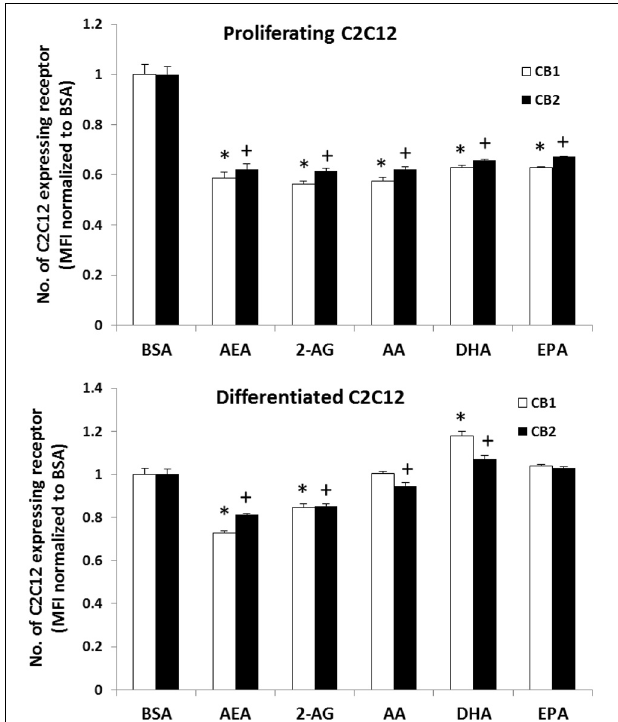
FIGURE 2 | FACS flow cytometry analysis of CB1 and CB2 expression in proliferating and differentiated C2C12 myoblast cultures treated with PUFA and EC. C2C12 cultures were treated with 25 μ M concentrations of respective treatments for 24h. The bars are the means ± SD (error bars) of 3 experiments performed in triplicate. The asterisk ( ∗ ) signifies difference compared to the BSA control for CB1 while the plus sign ( + ) indicates difference compared to the BSA control for CB2. In proliferating cells all treatments were different compared to the BSA vehicle control. In differentiating cells compared to the BSA vehicle control, DHA had higher CB1 and CB2 values and AEA and 2-AG were lower values but CB2 was lower in the AA